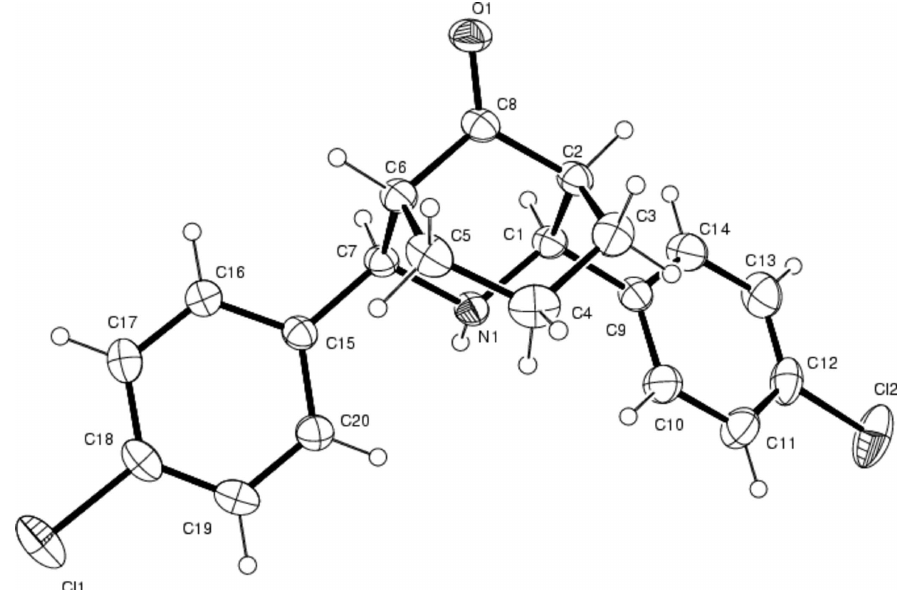
Figure 1 ORTEP of the molecule with atoms represented as 30% probability ellipsoids.